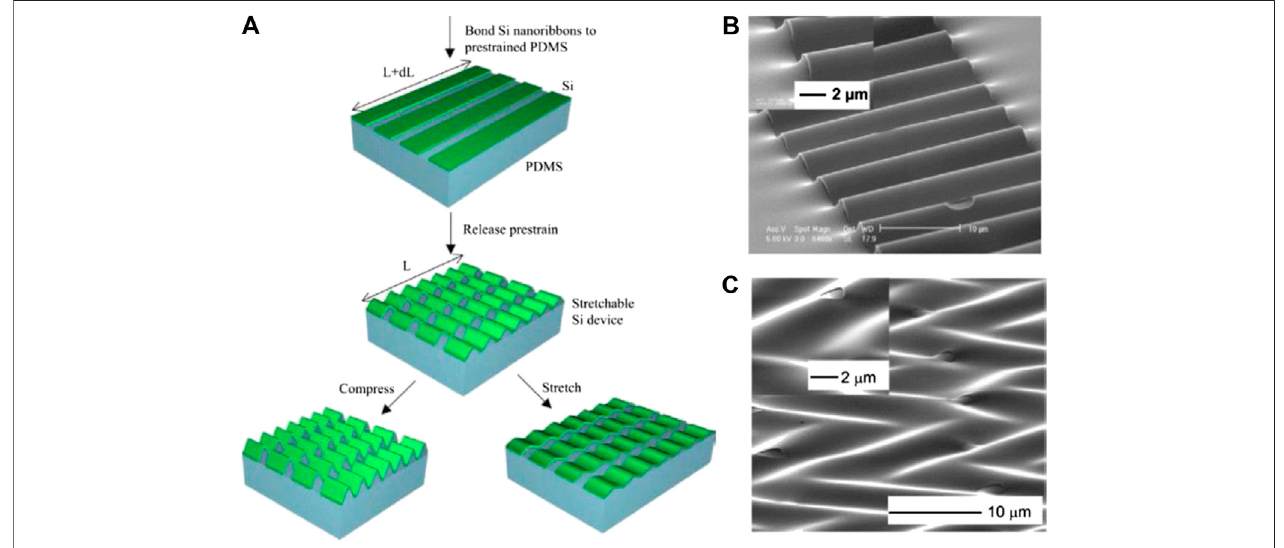
FIGURE 3 | (A) Schematic illustration of the process for fabricating buckled wavy single-crystal silicon ribbons on a PDMS substrate. (B) , (C) SEM images of stretchable nanoribbons and stretchable nanomembranes (Song et al., 2009). Reproduced with permission.